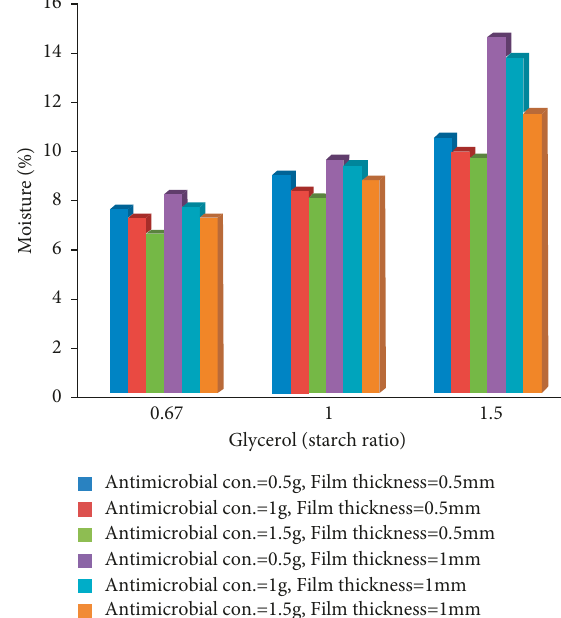
Figure 4: Moisture content of packaging film at different glycerol/ starch